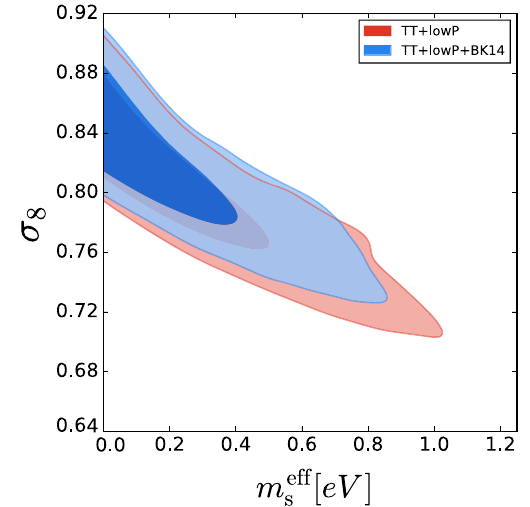
Fig. 3 1 σ and 2 σ marginalized contours for σ 8 vs. m eff s [eV] in the (cid:2) CDM + r + N + m eff eff 0 . 05 s model with the following combinations: TT + lowP and TT + lowP + BK14. Adding BK14 leads to slightly higher σ 8 ; and due to large anti-correlation present between σ 8 and m eff s , slightly stronger bound on m eff s is obtained